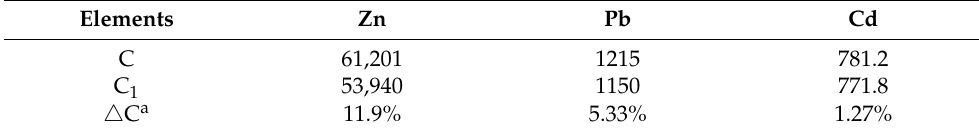
Figure 6. Pedigree diagram of element clustering in samples C ( a ) and C 1 ( b ). Table 5. Comparison element content changes in samples C and C 1